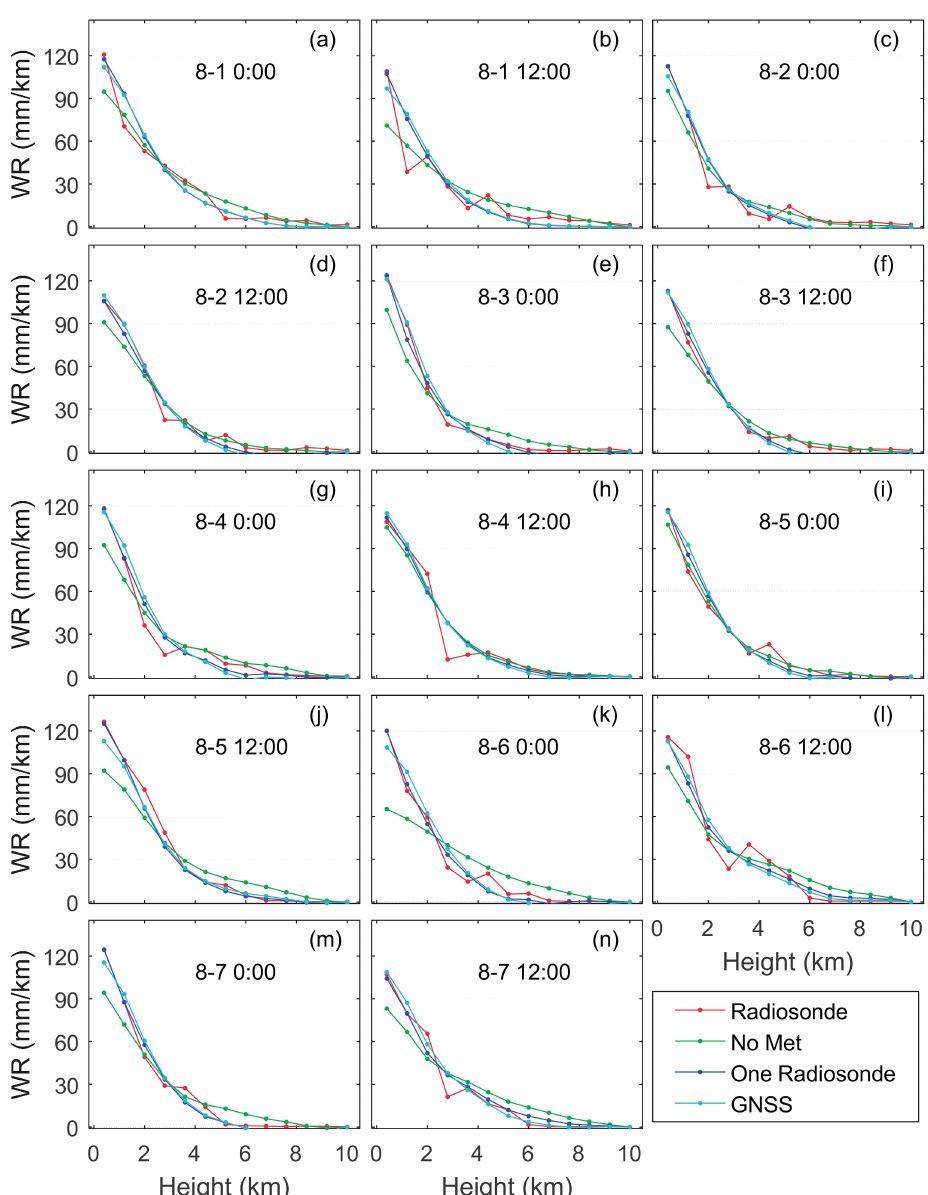
Figure 5. Comparisons between the tomography results and radiosonde results during 1 August to 7 August. Green lines indicate the a priori information free strategy; Blue lines indicate the one radiosonde constrained strategy; Cyan lines indicate the GNSS meteorological data constrained strategy. ( a – n ): comparisons between WR at different time